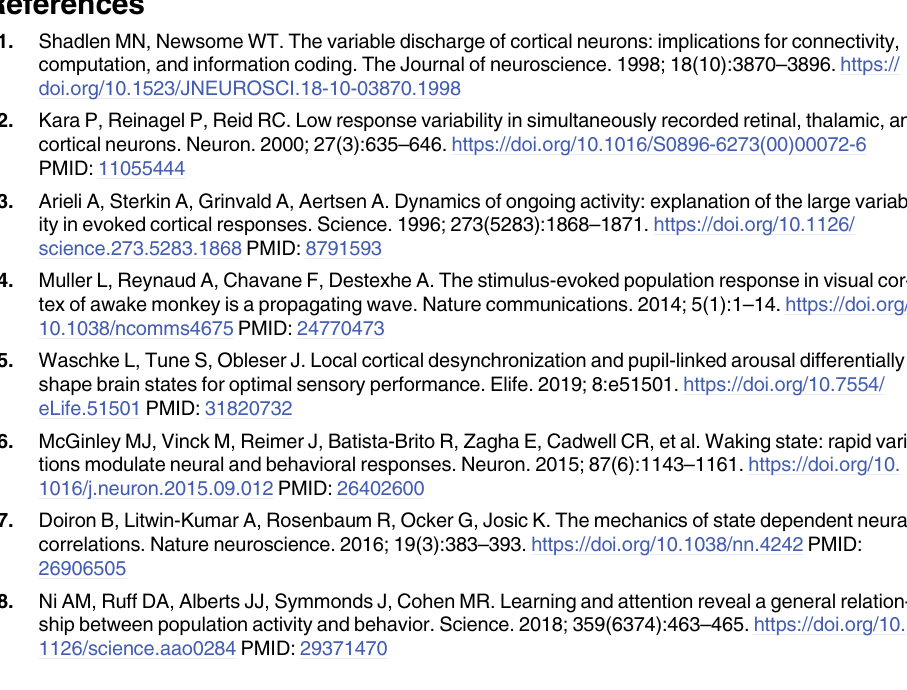
S5 Fig. Related to Methods: Maximal Lyapunov exponent. Convergence of the maximal Lya- punov exponent as a function of the number of perturbations n (Eq 10). Each curve is the MLE for one solution. There are 10 chaotic solutions (MLE > 0.005) and 5 periodic solutions (MLE < 0.002).